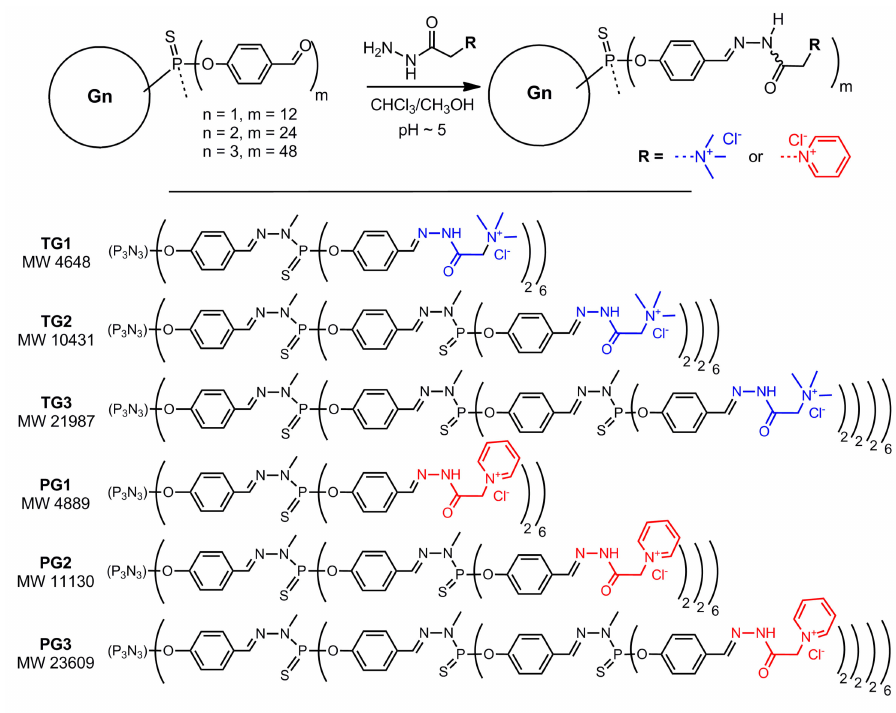
Figure 2. Synthesis and structures of acetohydrazone-terminated phosphorus